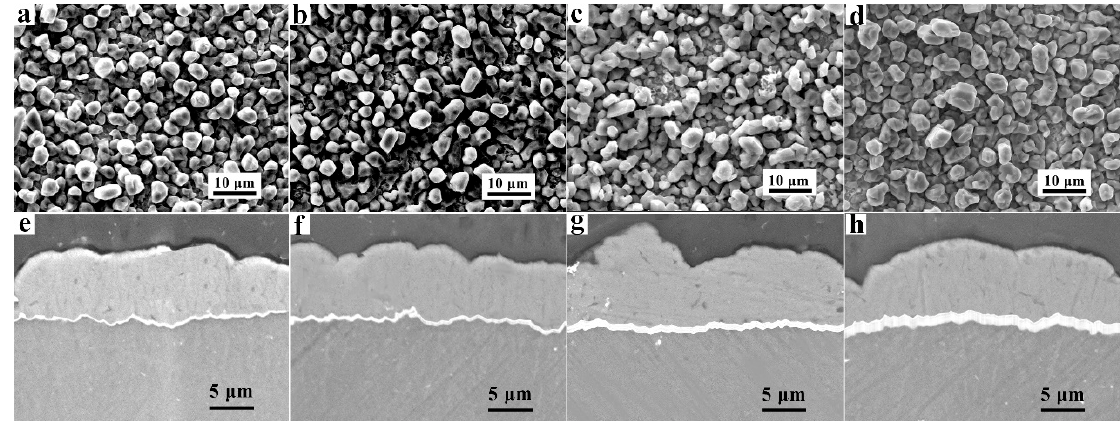
Figure 2. ( a – d ) The SEM planar view and ( e – h ) the cross-sectional morphologies of the Al coatings on the AZ91D Mg alloy with Zn immersion for ( a , e ) 2 min, ( b , f ) 4 min, ( c , g ) 6 min, and ( d , h ) 8 min.